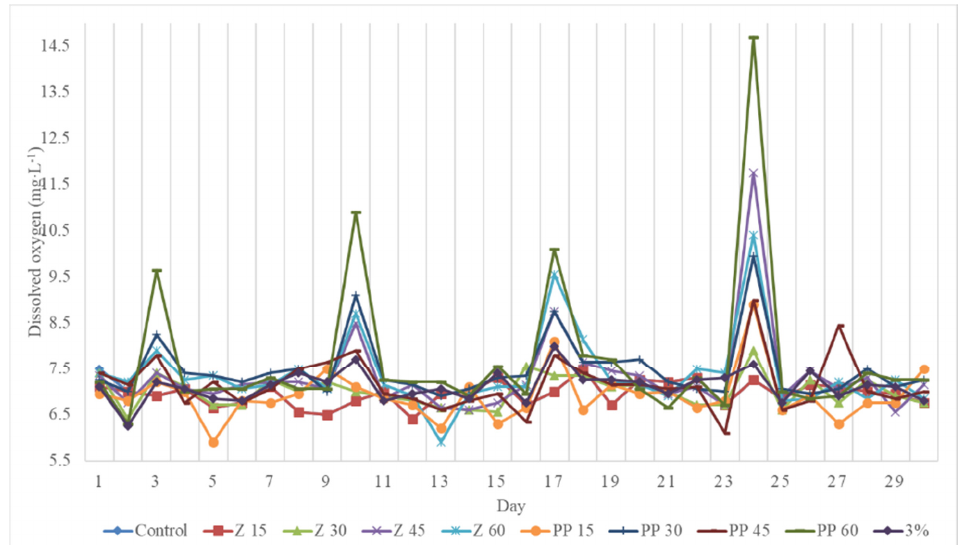
Figure 2. Effects of the rate of two hydrogen peroxide products, ZeroTol (Z) and 3% hydrogen per- oxide (3%) (45 mL Z, 60 mL Z, 45mL Z, and 50 mL 3%, and 60 mL Z and 50 mL 3%) on dissolved oxygen (DO) levels of nutrient solution in ebb and flow hydroponic systems at OSU research green- houses in Stillwater, OK. Treatments were applied weekly starting on day three. Stars show signif- icant differences between at least two treatments that day for experiment one.